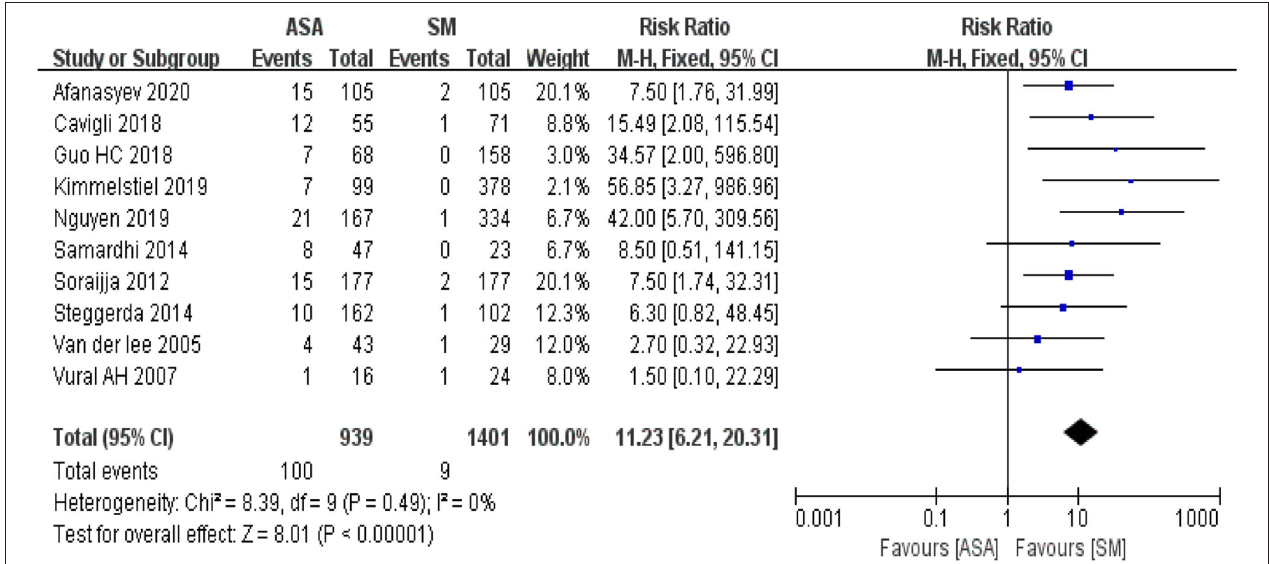
FIGURE 6 | The forest map for the Meta analyses of risk of reoperation. M-H, Mantel-Haenszelt test; CI, confidence interval; Fixed, fixed effect model.